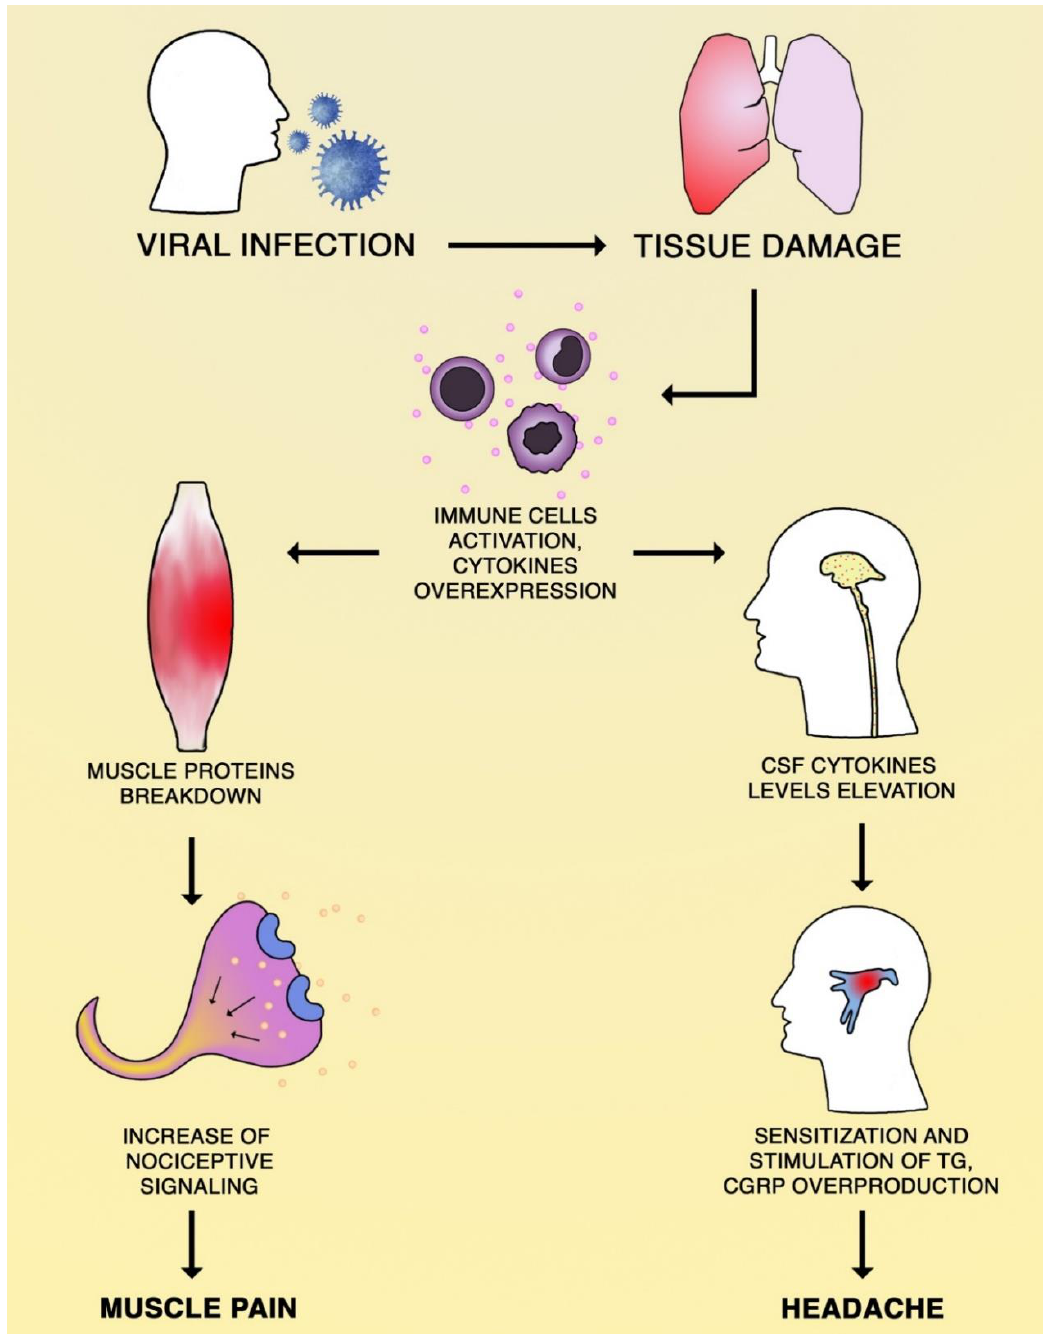
Figure 1. Putative mechanisms of myalgia and headache during viral infection. The specific mechanism of headache during infection remains unclear. The assumed pathomechanisms involve the overexpression of proinflammatory cytokines, such as TNF-α and PGE2, in the cerebrospinal fluid (CSF), which sensitize and stimulate trigeminal ganglia (TG) neurons to produce calcitonin gene- related peptide (CGRP). CGRP has a crucial role in the pathogenesis of migraine, influencing arteries’ dilatation and possibly to direct a nociceptive transmission. The myalgia during viral infection is believed to be the effect of proinflammatory cytokines influence on muscle tissue. TNF-α is responsible for the intensified breakdown of muscle proteins and PGE2 could increase the nociceptive signaling.